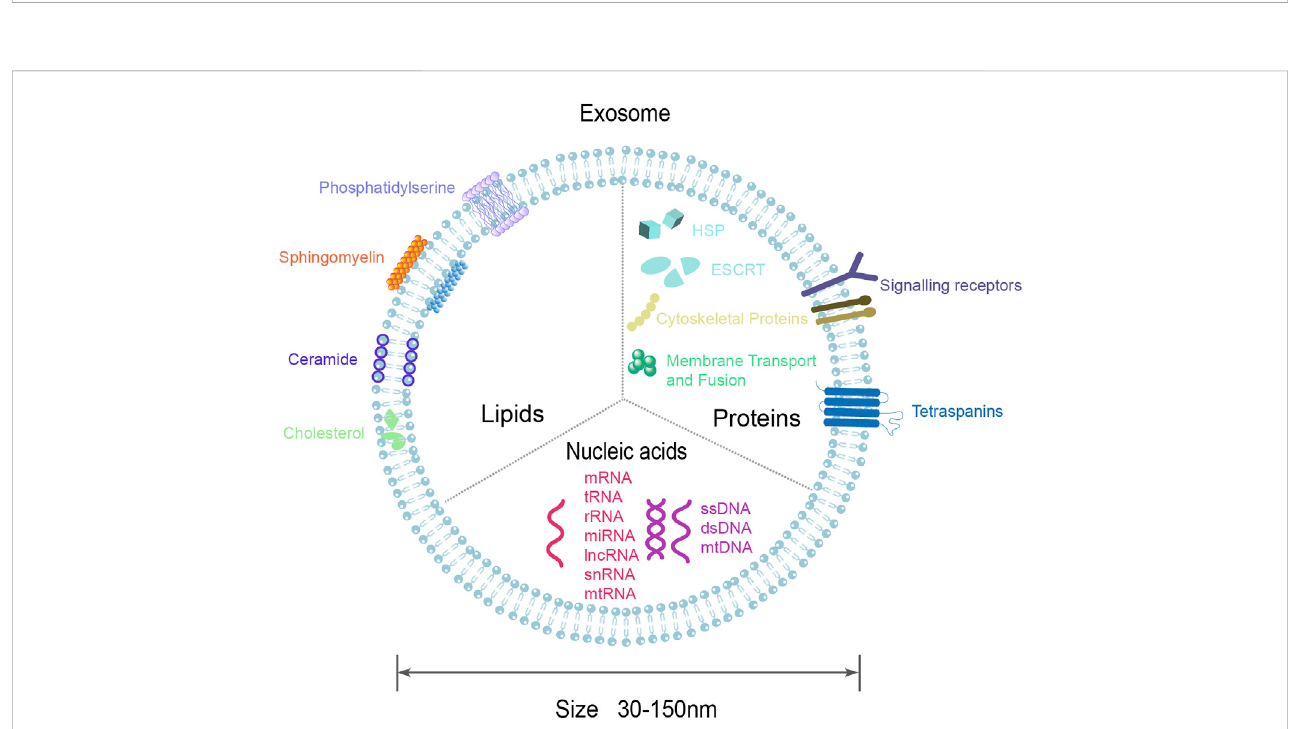
FIGURE 2 Diagram of exosomal molecular composition. Exosomes are composed of lipid bilayers that carry a variety of biomolecules, including proteins, DNA, RNA, lipids, etc.